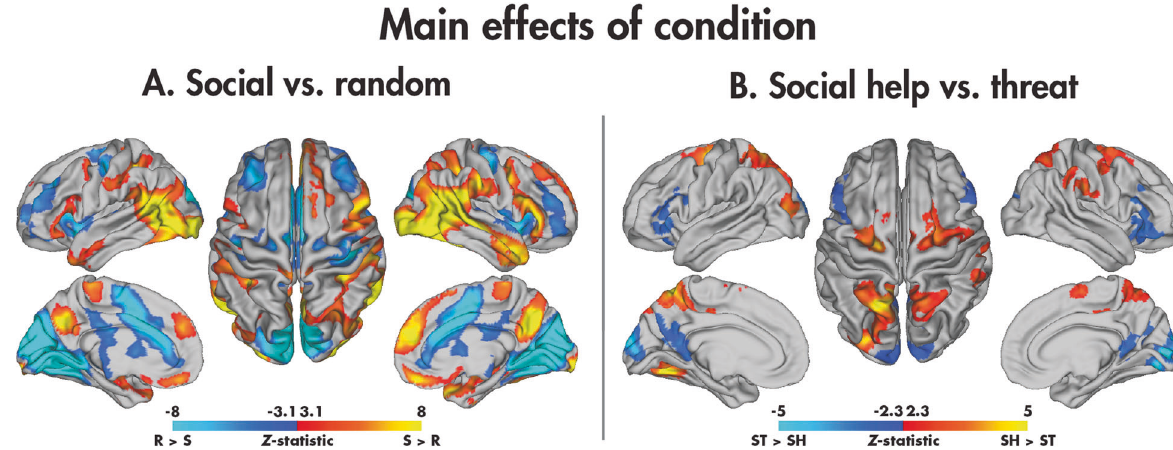
Fig. 2 Main effects of the condition in the SAT. Signi fi cant ( p corr < 0.05) across-group main effects are shown for the social vs. random ( A ) and social help vs. social threat ( B ) contrasts.